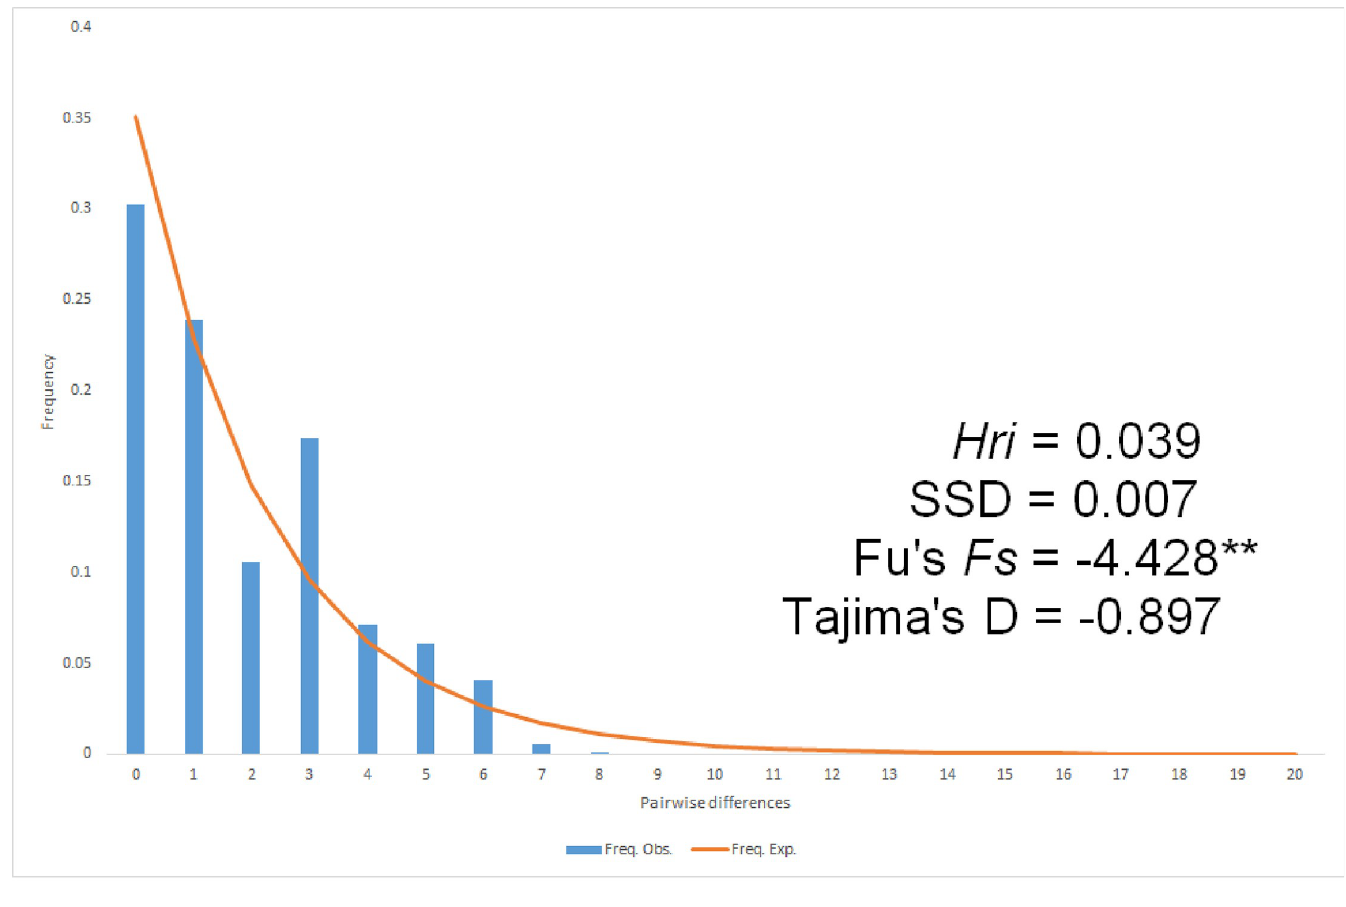
Fig 7. Observed and expected mismatch distribution of the Fukuoka A